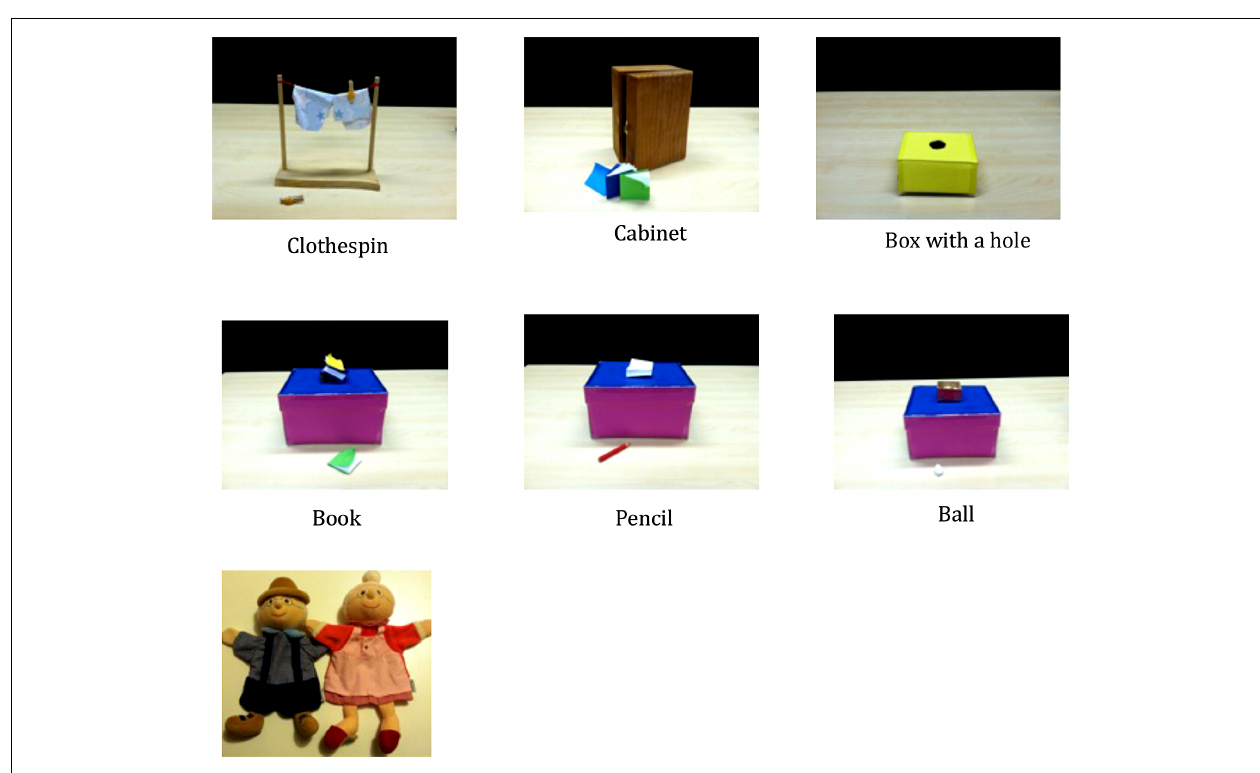
FIGURE 1 | Photograph of stimuli used in the